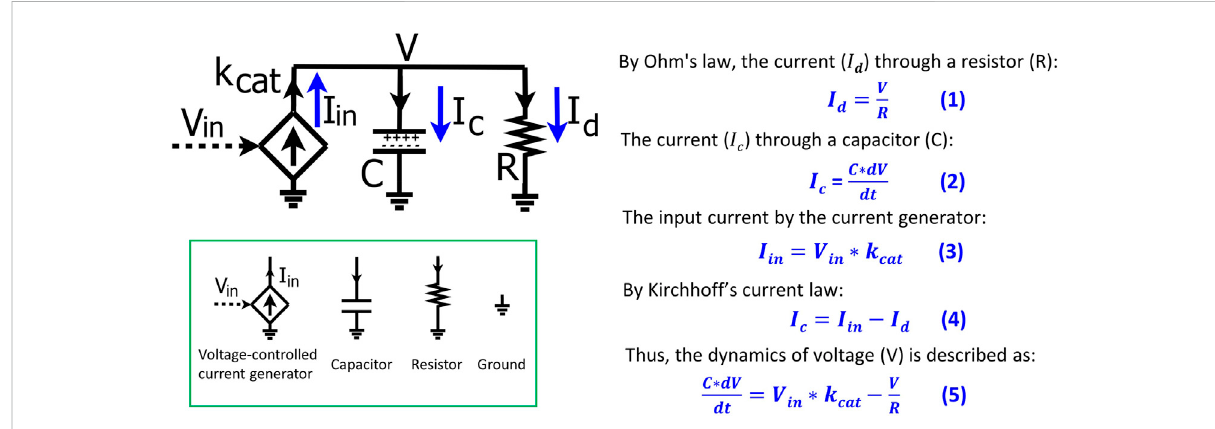
FIGURE 1 The basics of a resistor-capacitor (RC) circuit fed by a transconductor input. The input current is generated by the transconductor (diamond symbol),i.e.,avoltage-controlledcurrentgeneratorthatconvertstheinputvoltage(V in )intotheinputcurrent(I in )withaconversionfactorofk cat .The dynamicsofthevoltage(V)overthecapacitor(C)andtheresistor(R)aredeterminedbytheinputcurrent(I in )andthecurrent(I d )throughtheresistor. Electronic circuit symbols are shown in the green